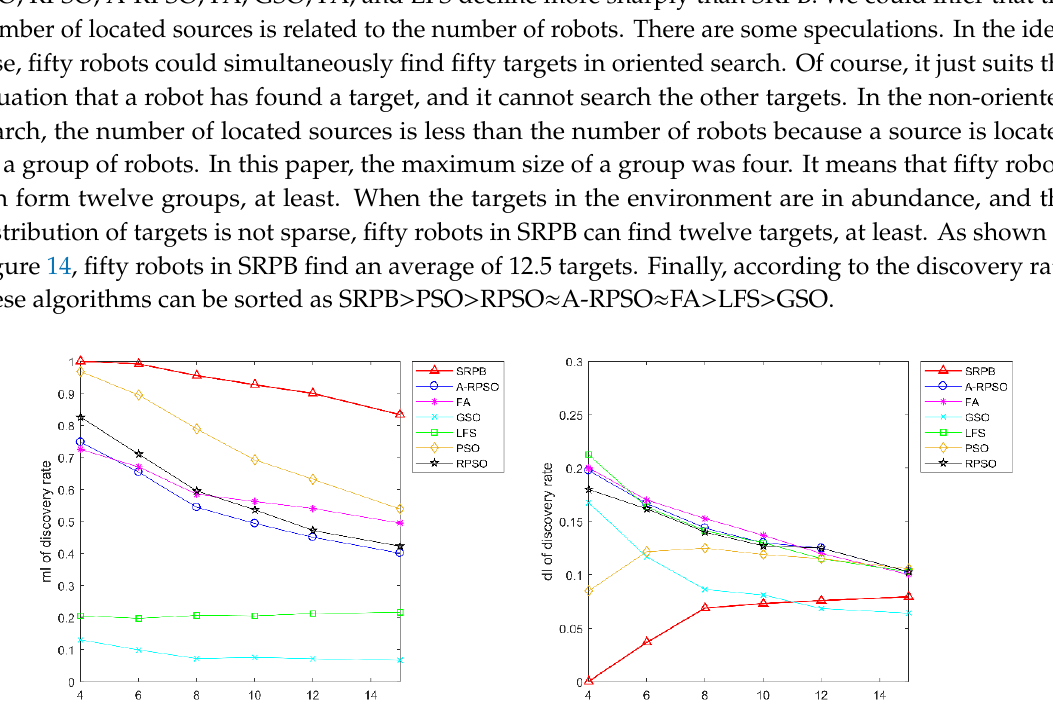
Figure 14. Discovery rate of the strategies. ( a ) mI of discovery rate; ( b ) dI of discovery